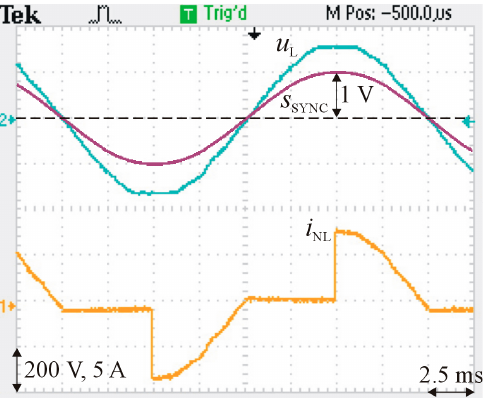
Figure 8. Waveforms of the grid voltage and NL current for a real, ‘soft’ power grid and the grid voltage–synchronous signal, at the output of the SYNC block. voltage–synchronous signal, at the output of the SYNC block.